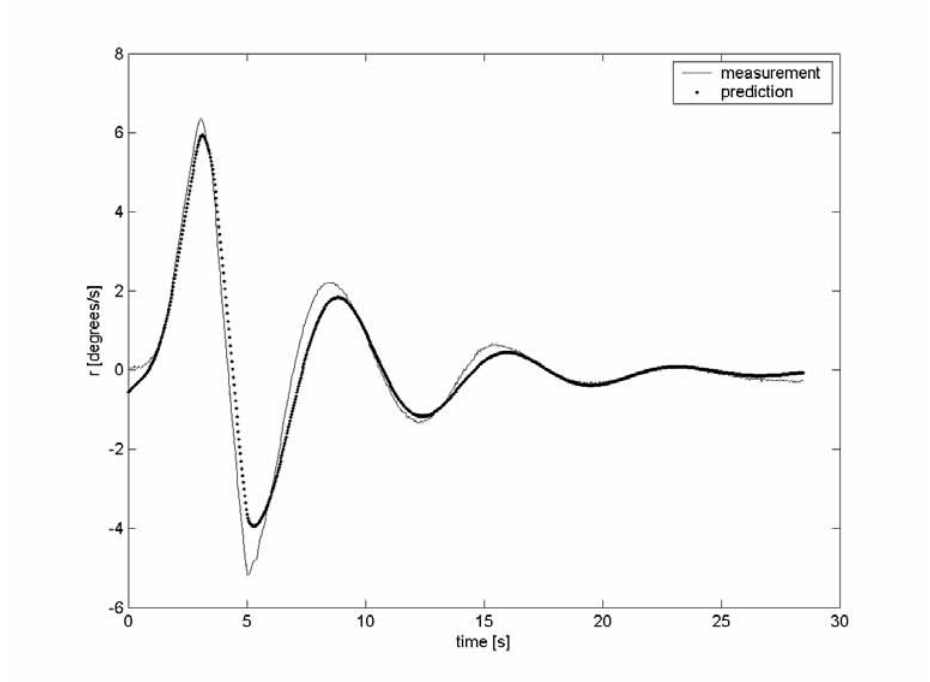
Fig. 10. Measured yaw angular rate and estimated values.